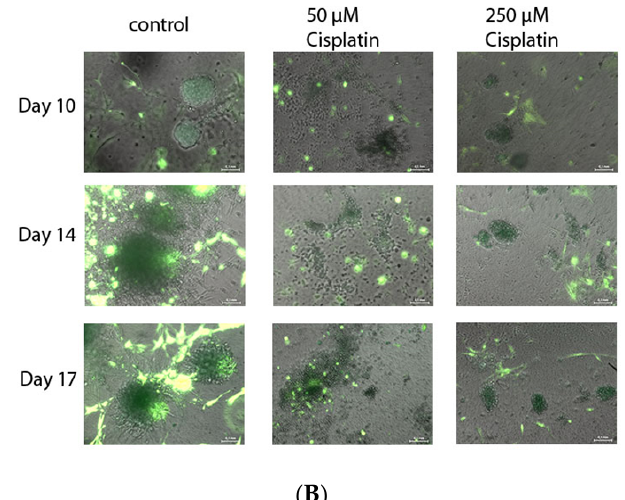
Figure 9. ( A ): The bar graph shows a significant reduction in spheroid size after treatment with both concentrations of cisplatin compared to control. ( B ): Fluorescence photomicrographs of hydrogel cultures containing H838GFP tumor spheroids (dark green), RFP fibroblasts (light green), inflammatory cells and endothelial cells after 10, 14 and 17 days of treatment with 50 μ M and 250 μ M. In comparison to control cultures, cisplatin does not reduce the number of fibroblasts but negatively affects the fibroblast network as well as fibroblast morphology which changes towards small spindle shaped cells. Measuring bar: 100 µm.